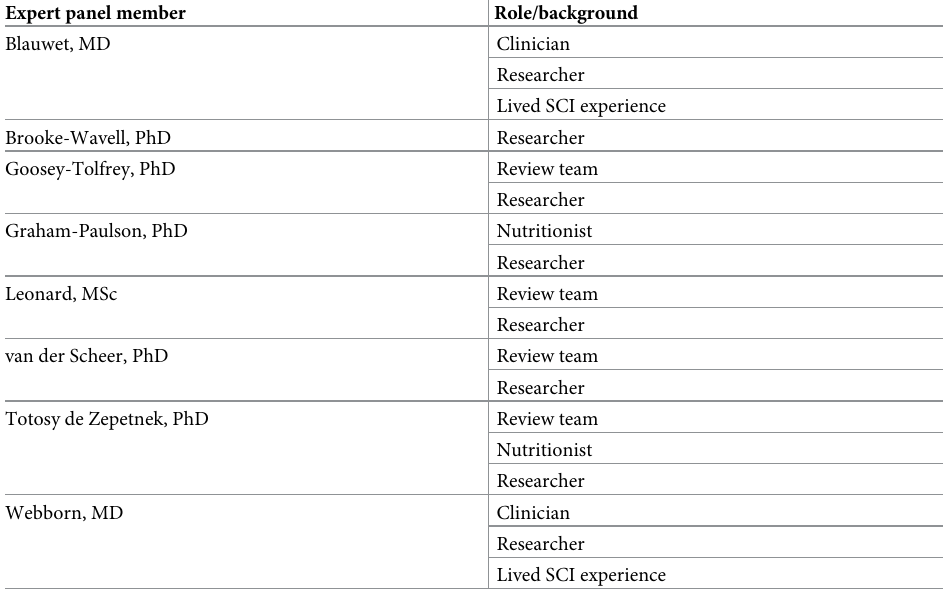
Table 1. The expert panel (n = 8) that collaboratively determined the scope and design of the review, and inter- preted its findings. Expert panel